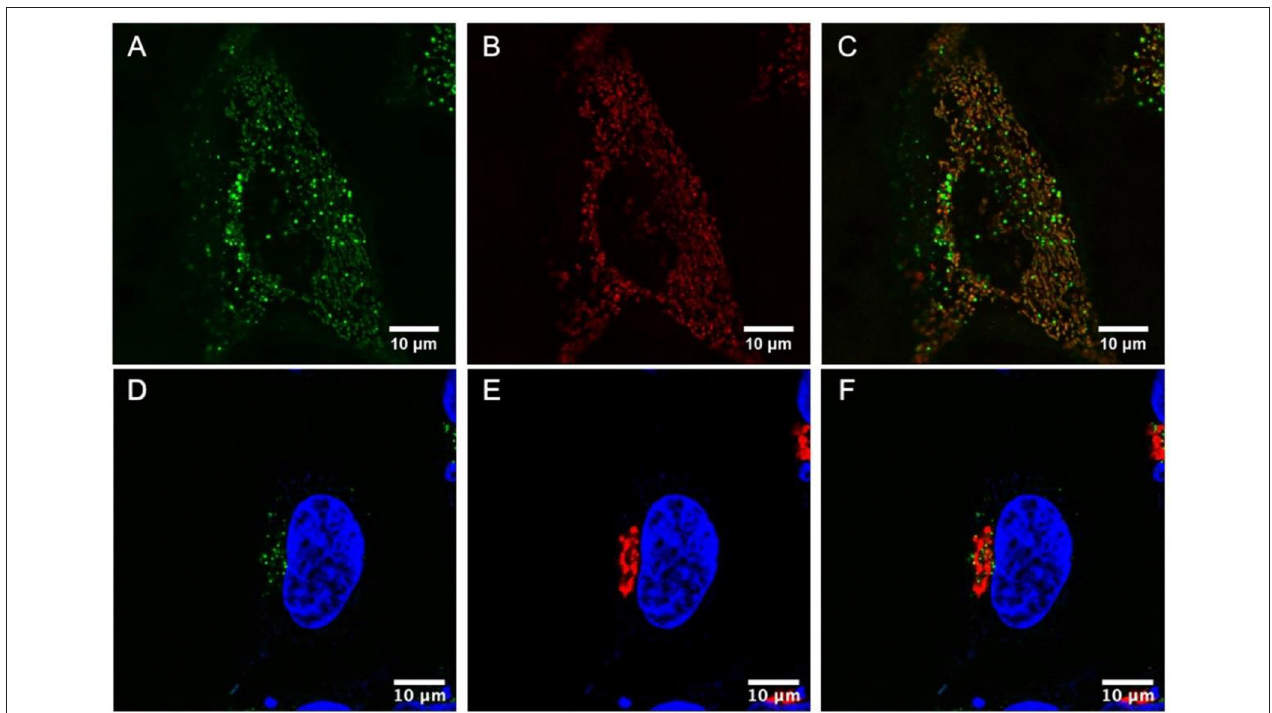
FIGURE 5 | Colocalization studies in live cells. HeLa cells were stained with Ru(dpp) 2 (16-ATAP)] 2 + (2.5 µ M, 24h) (A) , then MitoTracker Deep Red (80nM) was added to the cells (B) , and their colocalization was confirmed (C) . HeLa cells were stained with [Ru(dpp) 2 (11-ATAP)] 2 + (2.5 µ M, 24h) and DAPI (550nM) (D) . Co-staining with CellLight Golgi-RFP (30 µ M in 2mL) (E) and overlay of the two channels revealed their strong colocalization (F)